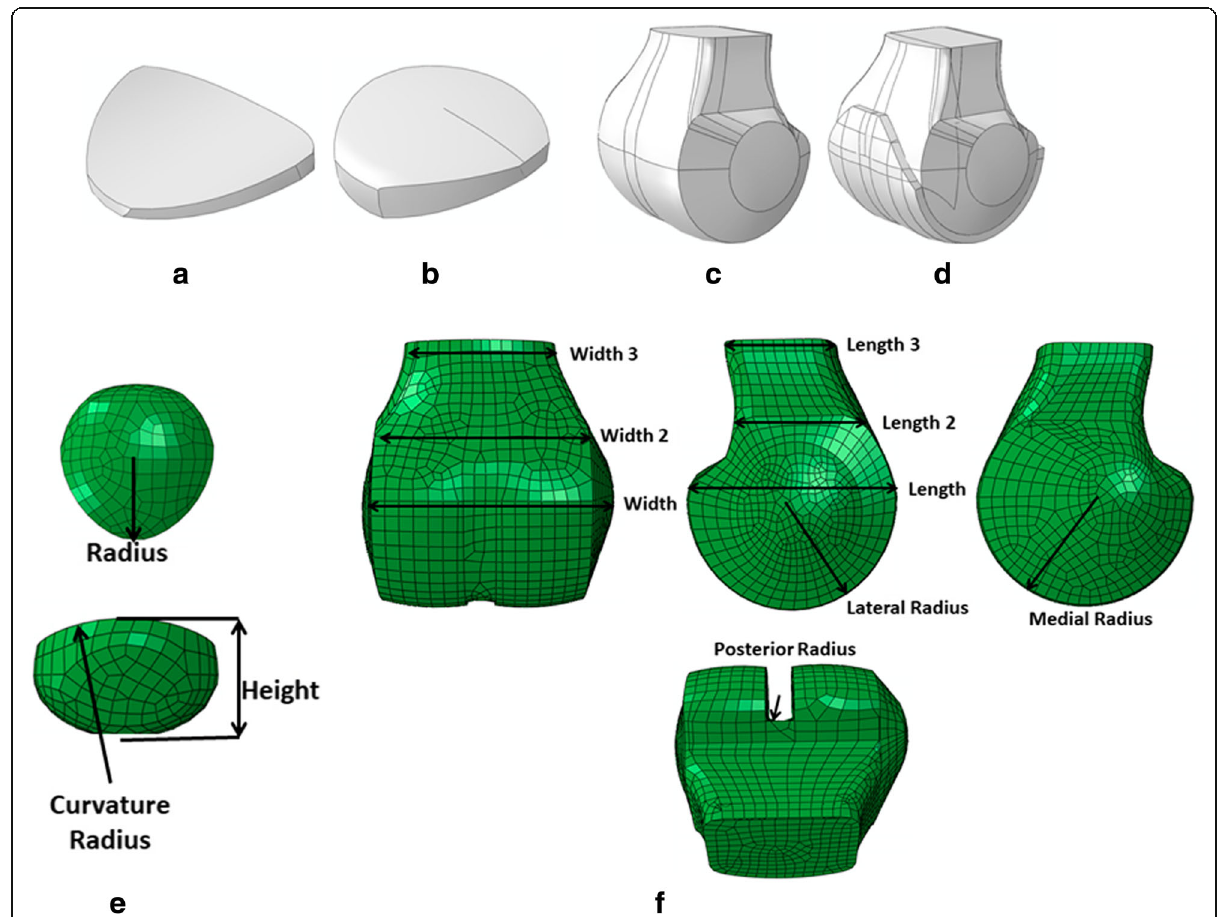
Fig. 1 Parametric geometry of the four main parts of the PFJ model: a Patellar cartilage; b patellar bone; c femoral bone; d femoral cartilage; e geometric parameters of the patellar bone; f geometric parameters of the femoral bone